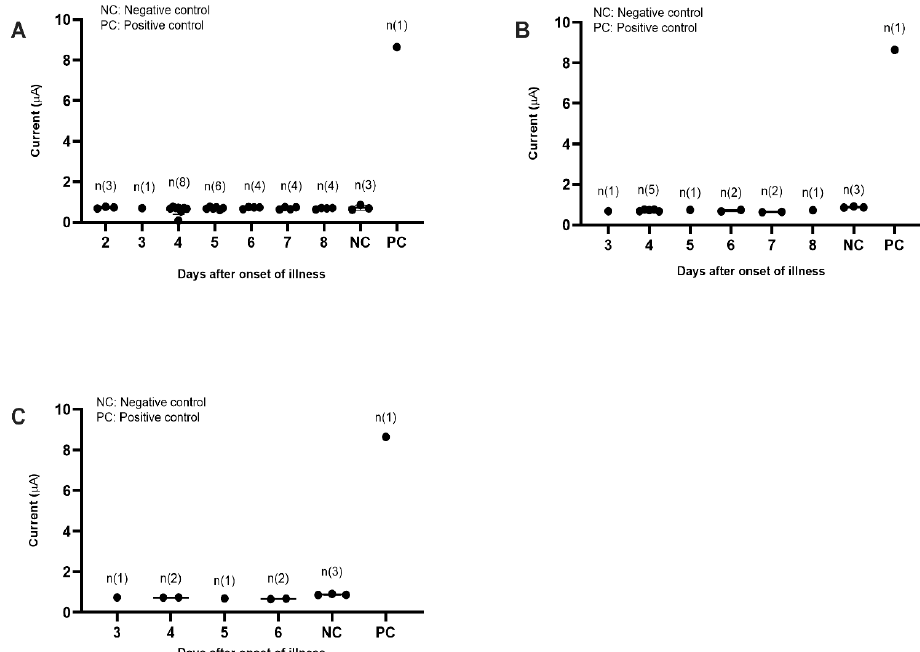
Figure 8. Diagnostic evaluation of the dengue IgM electrochemical biosensor using dengue negative sera. ( A ) The electrochemical response generated against dengue IgM and NS1 negative samples. ( B ) The electrochemical response generated against dengue IgM negative but NS1 positive samples (primary dengue). ( C ) The electrochemical response generated against dengue IgM negative samples (secondary infection).